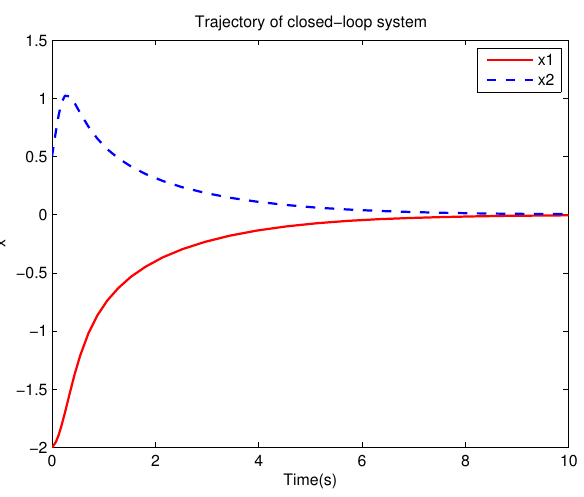
Figure 10. Closed loop system trajectory, p 1 = − 1, p 2 = 2, p 3 = 0.